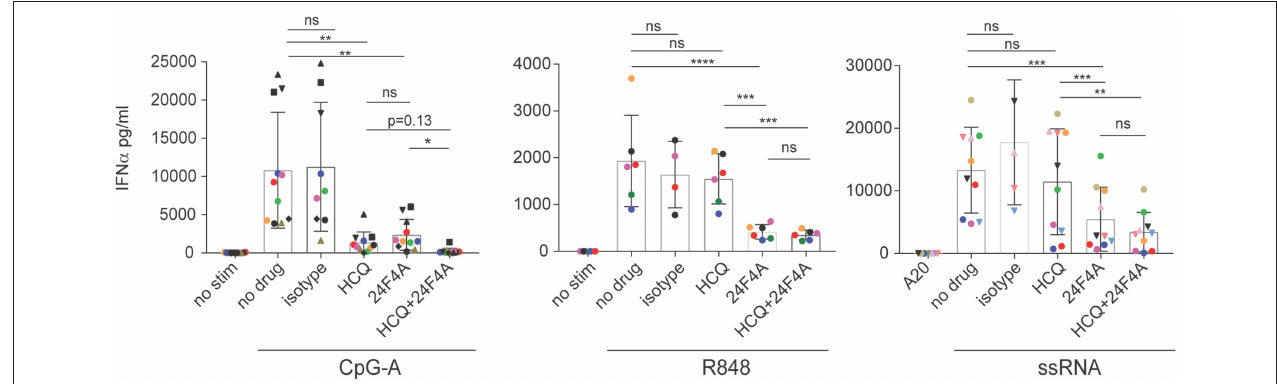
FIGURE 1 | Effect of HCQ and BIIB059 on IFN α release from human whole blood stimulated with CpG-A, R848, or ssRNA. Whole blood from human healthy donors was stimulated or not with CpG-A (10 µ M), R848 (1 µ M), or ssRNA (4 µ g/ml) complexed with pARG in presence or absence of HCQ (550ng/ml), isotype control mAb (10 µ g/ml), 24F4A (10 µ g/ml) or a combination of both HCQ and 24F4A. Secreted IFN α was measured 18h after stimulation in the serum using ELISA. Same color and/or shape-coded data points represent data obtained from a given donor ( n = at least 6 donors). Statistical tests were performed using paired one-way Anova (ns, non-significant p ≥ 0.05, * p < 0.05, ** p < 0.01, *** p < 0.001, **** p <